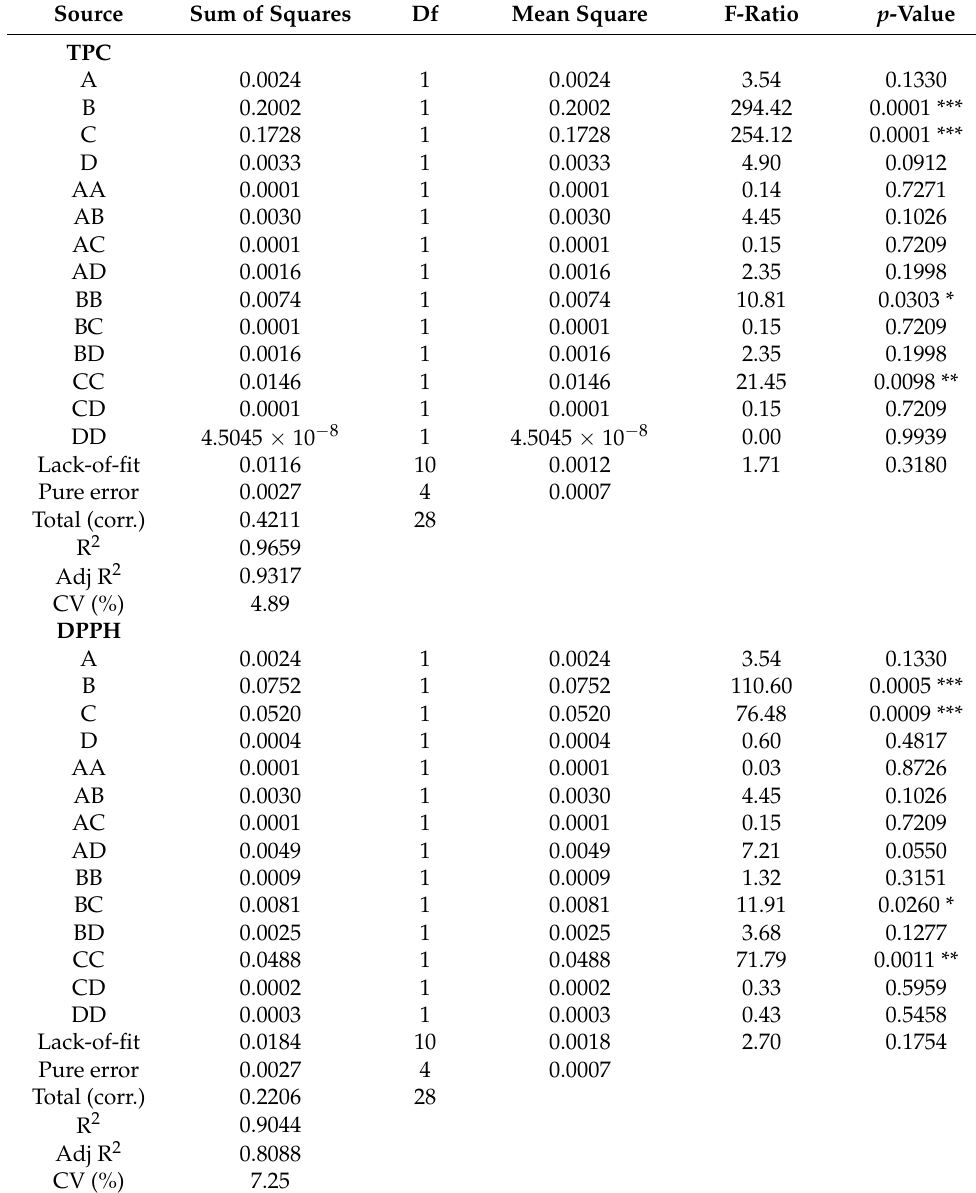
Table 3. ANOVA results for response surface quadratic models of TS extraction by